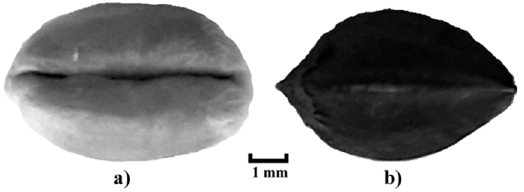
Figure 1. Individual particles of material: ( a ) wheat, ( b ) buckwheat. The force of static ( F sta ) and kinetic ( F kin ) friction was studied for four levels of mois- ture ( M c 9.5%, 13.5%, 17.5% and 21.5%). Obtaining the specified (assumed) moisture con-